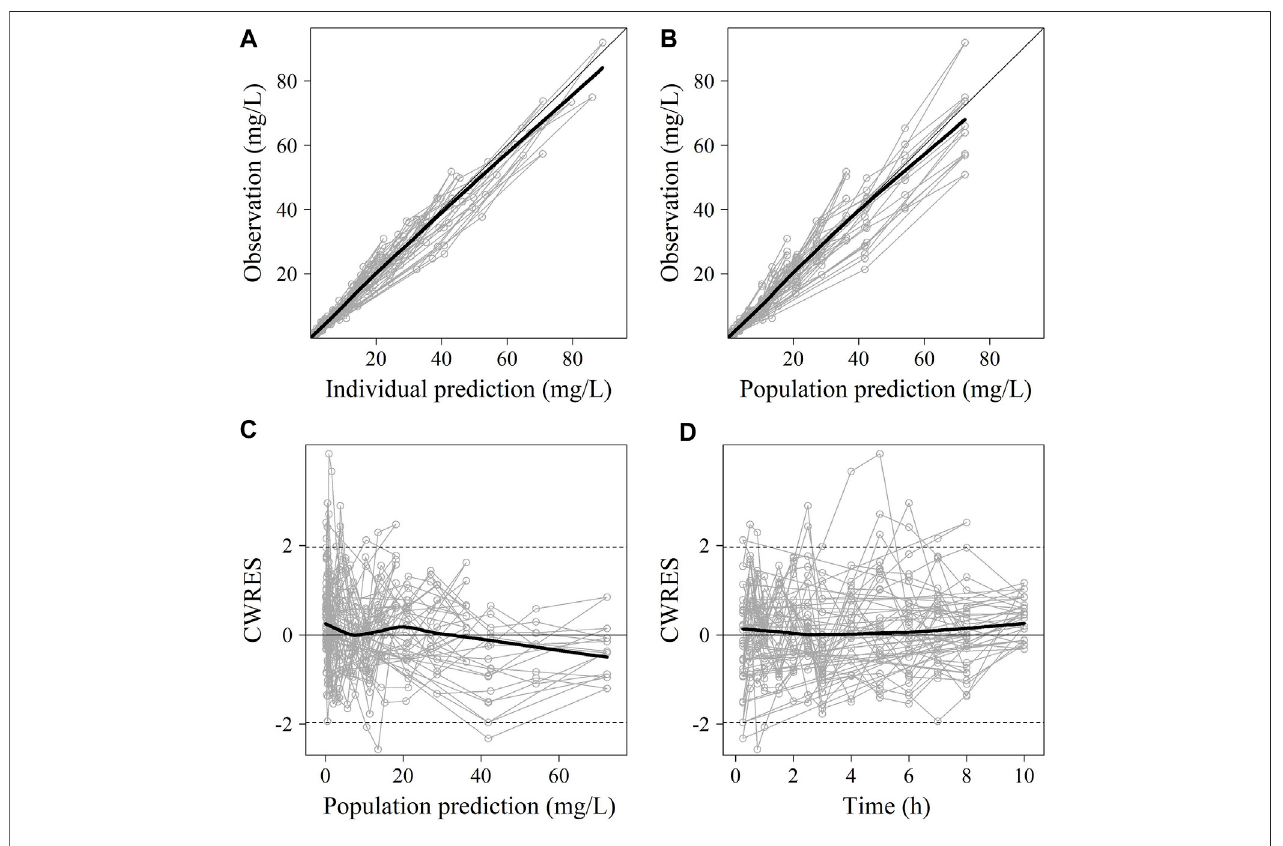
FIGURE 2 | The goodness-of- fi t plots of sulbactam Pop-PK model. (A) Relationship between observed versus IPRED of PK; (B) Relationship between observed versus PRED of PK; (C) CWRES at different PRED; (D) CWRES at different time points. CWRES: conditional weighted residuals; PRED: predicted value; IPRED: individual predicted value. The thin solid lines represent the x = y lines. The thick solid lines are the trend lines.